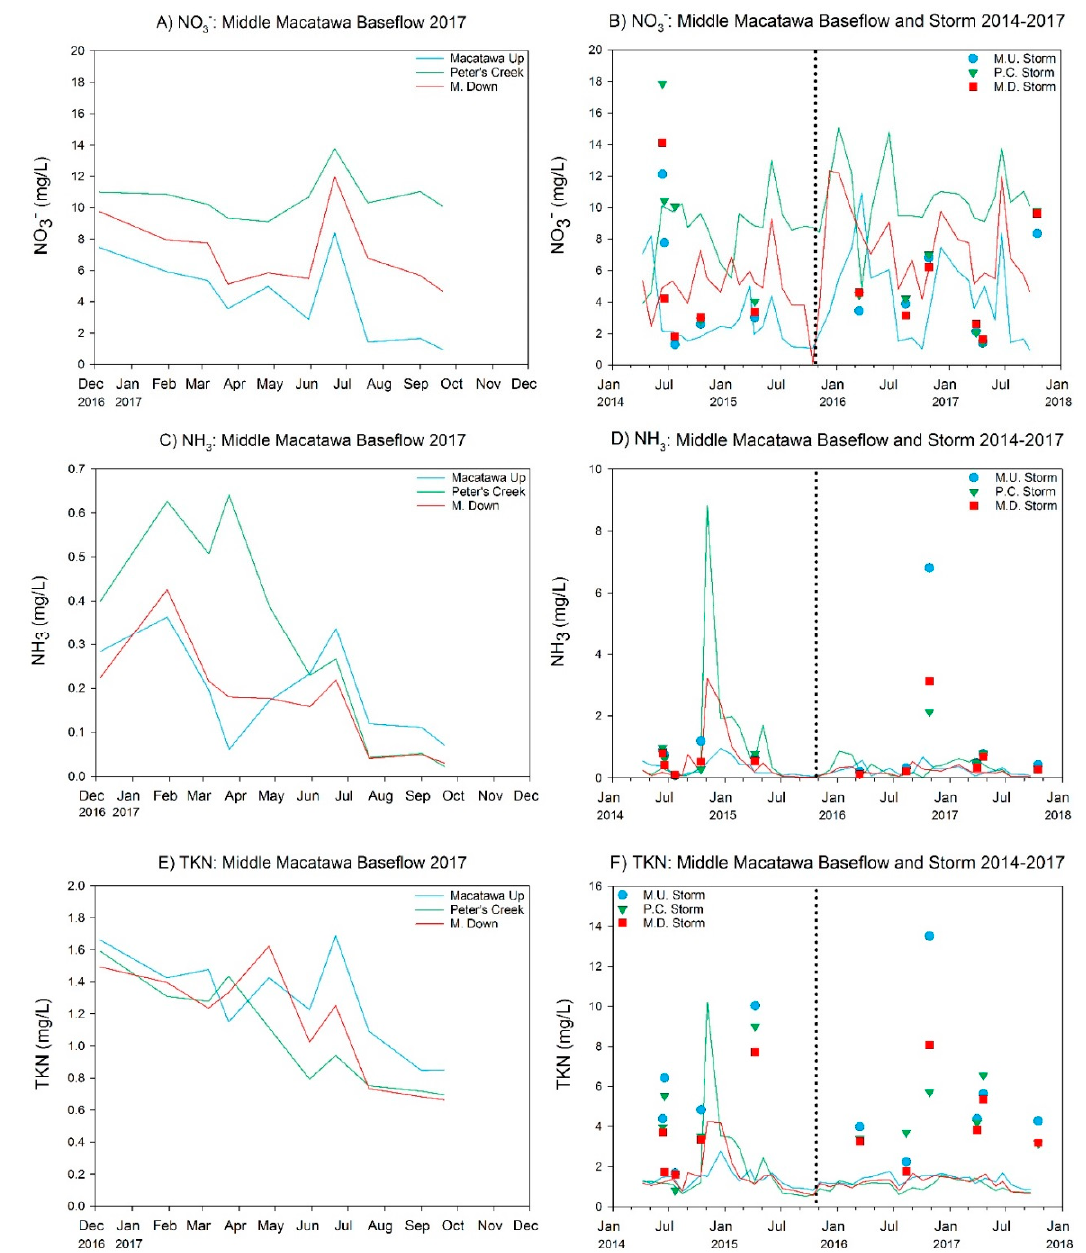
Figure 4. Nitrate (NO − ), ammonia (NH 3 ), and total Kjeldahl nitrogen (TKN) concentrations measured at the Middle Macatawa restoration site in 2017 ( A , C , E ) and over total project history ( B , D ,E). See Figure 3 caption for more explanation.